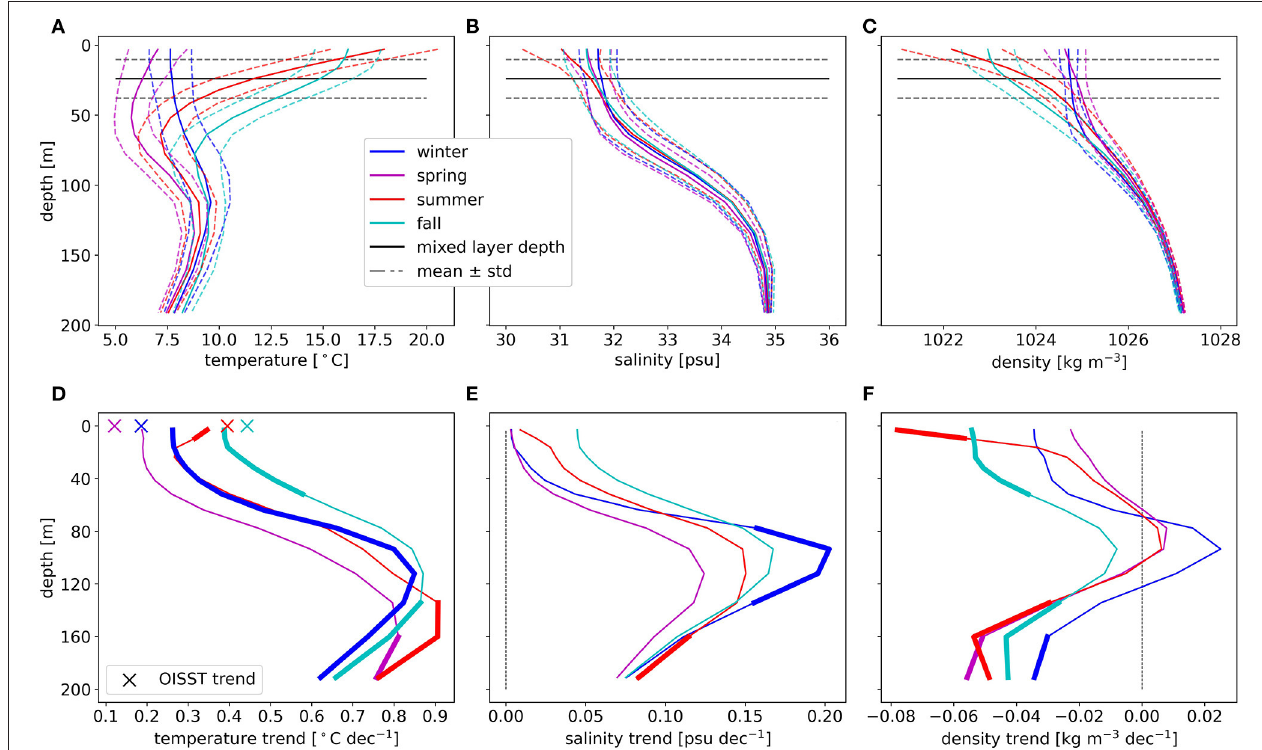
FIGURE 5 | Shelf hydrography; seasonal and horizontal averages and standard deviations for temperature (A) , salinity (B) , and density (C) and mixed layer depth (A–C) plus spatial mean seasonal temperature (D) , salinity (E) , and density (F) trends over the shelf region (ecoboxes, see Figure 1 ) for the time period from 1982 to 2019; crosses in (D) mark the observed surface temperature trends, thick lines indicate significance on the 95%